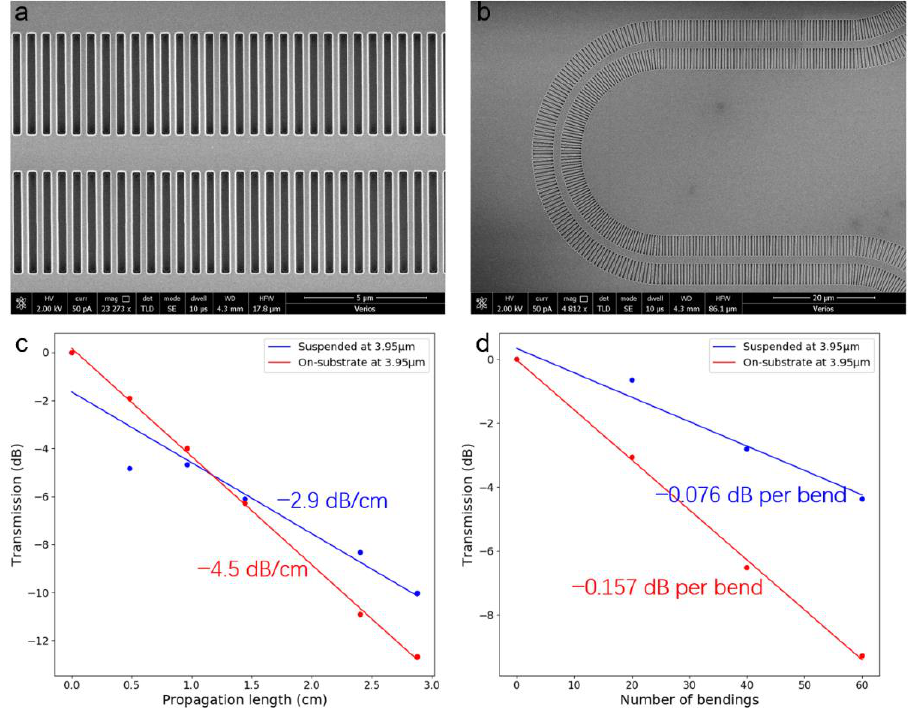
Figure 5. ( a , b ) SEM photos of the straight and bending waveguide. ( c ) Measurements of the propagation loss. ( d ) Measurements of the bending loss.